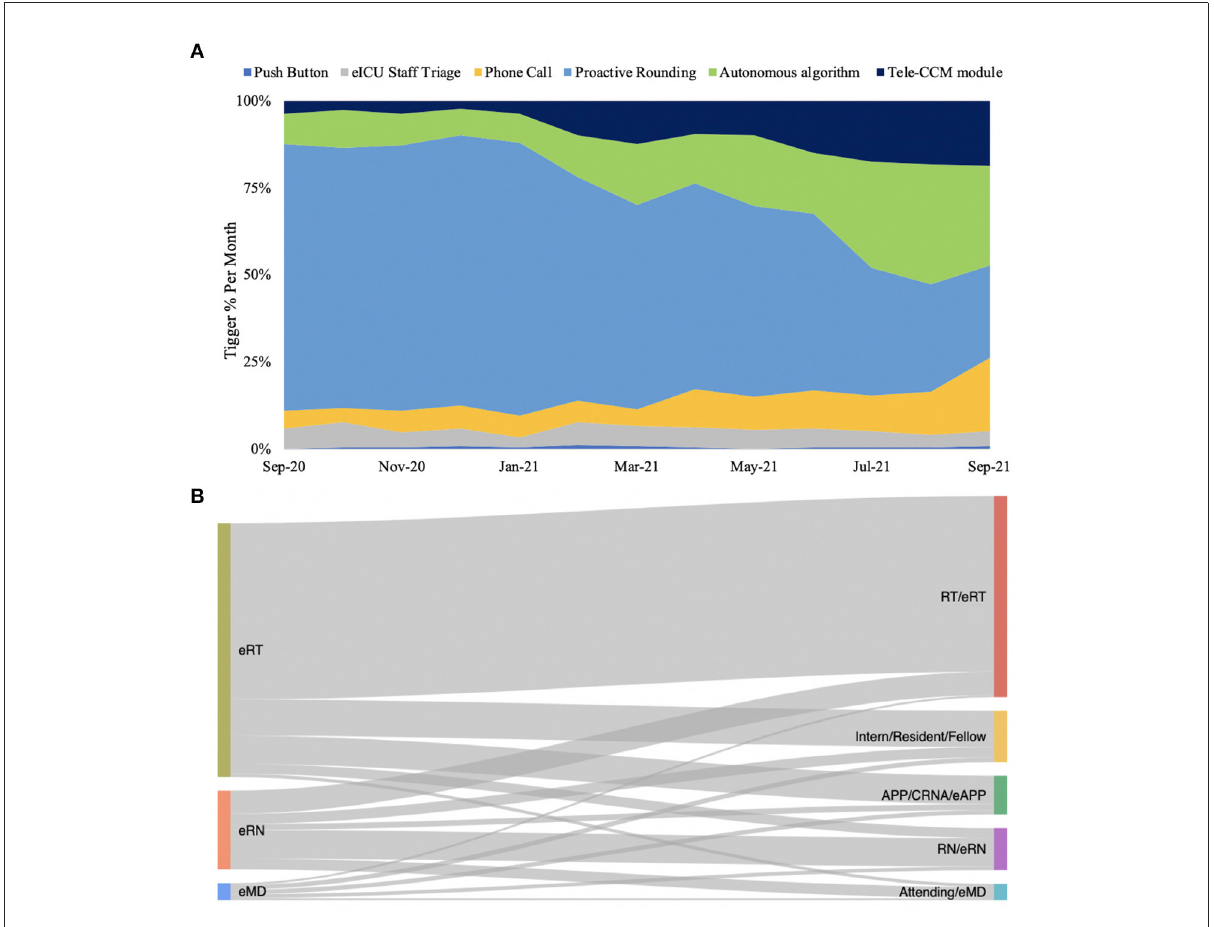
FIGURE3 Push button was the greatest trigger for eMD, eRN and eRTs overall but there was a slight increase in Sniffer and Phone calls as triggers near the end of the year (A) , with the most significant amount of communication involving RT/eRTs (B) .